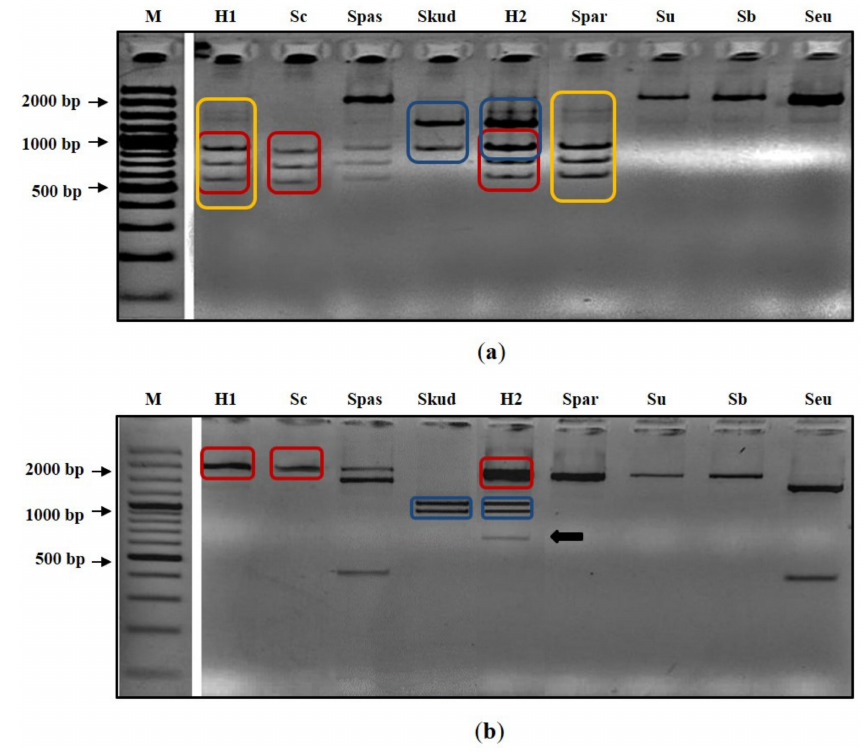
Figure 3. Patterns of HIS4 PCR fragment after digestion with Hind III ( a ) and Ecor V ( b ) restriction enzymes, H1, H2: isolates investigated, Sb: S. bayanus DBVPG 8001, Sc: S. cerevisiae CBS 1171, Skud: S. kudriavzevii CBS 8840, Spar: S. paradoxus CBS 432, Spas: S. pastorianus VTT-A63015,